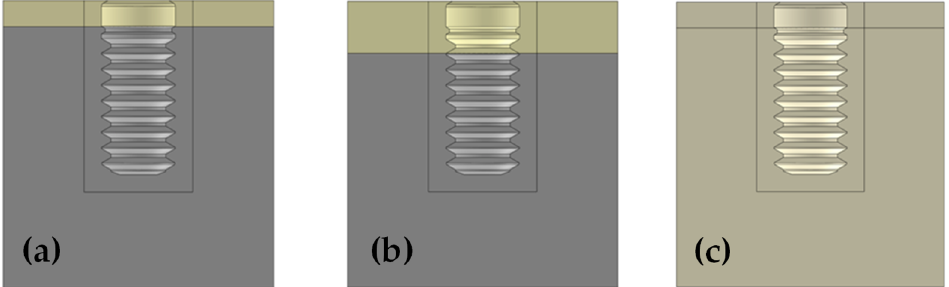
Figure 3. 3D model simulating dental implants placed in bone type III ( a ), II ( b ) and bone type 0-I ( c ).